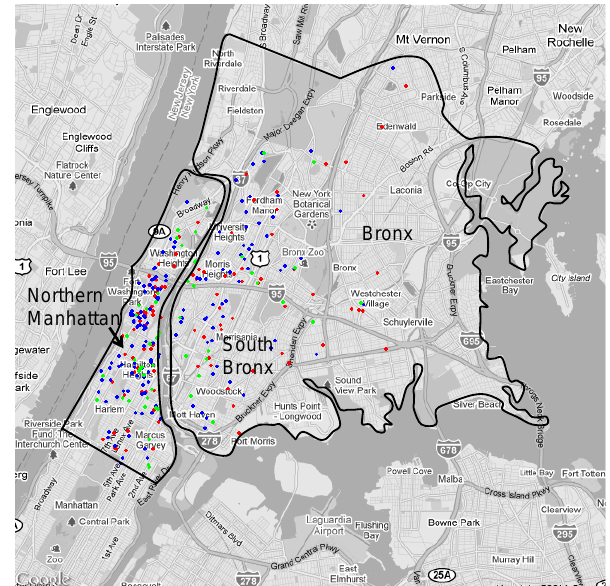
Northern Manhattan and the Bronx areas are illustrated by the solid black line. Circles represent residences of each participant and the color indicates different FL: Red (0–2nd FL), blue (3rd–5th FL), and green (6th–32nd FL). Map was generated by using R